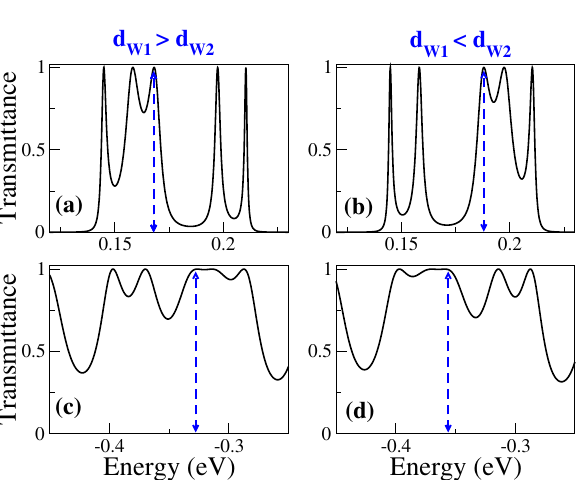
Figure 4. Transmission bands of BPGGSLs in which transparent states are clearly manifested. ( a ) and ( b ) correspond to electron transmission bands, while ( c ) and ( d ) to hole transmission bands. The resonance associated to the transparent state is indicated with the dashed-blue vertical arrow. The angle of incidence in all cases is θ = 45 ◦ . The superlattice parameters of ( a ) and ( c ) are the same as in Fig. 2 and the ones of ( b ) and ( d ) are the same as in Fig.